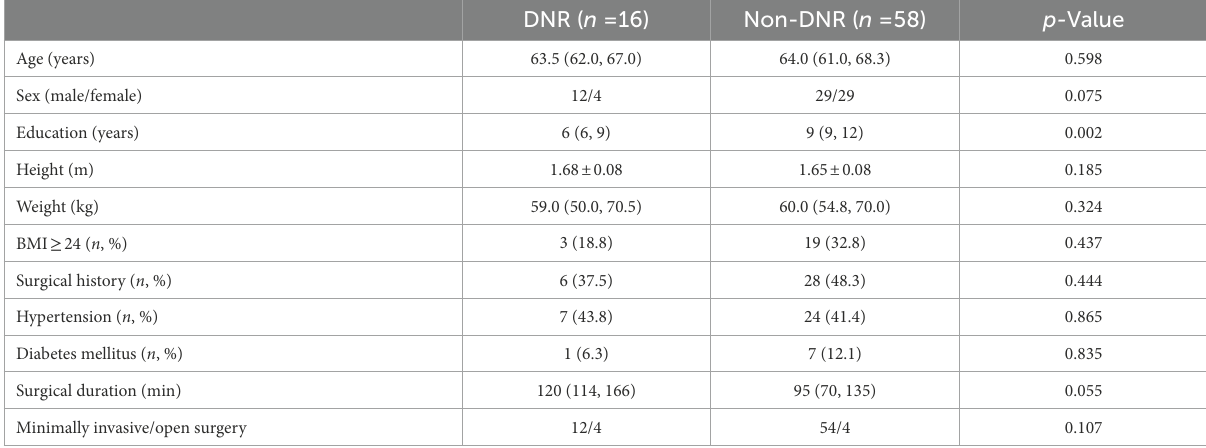
TABLE 1 Baseline